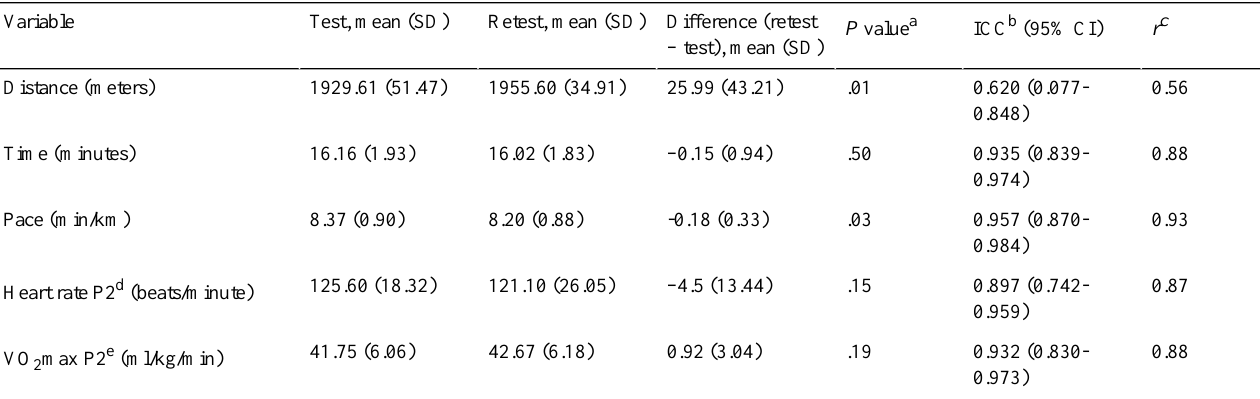
Table 4. Reliability of 2kmFIT-App (Android version) based on test-retest analysis with the